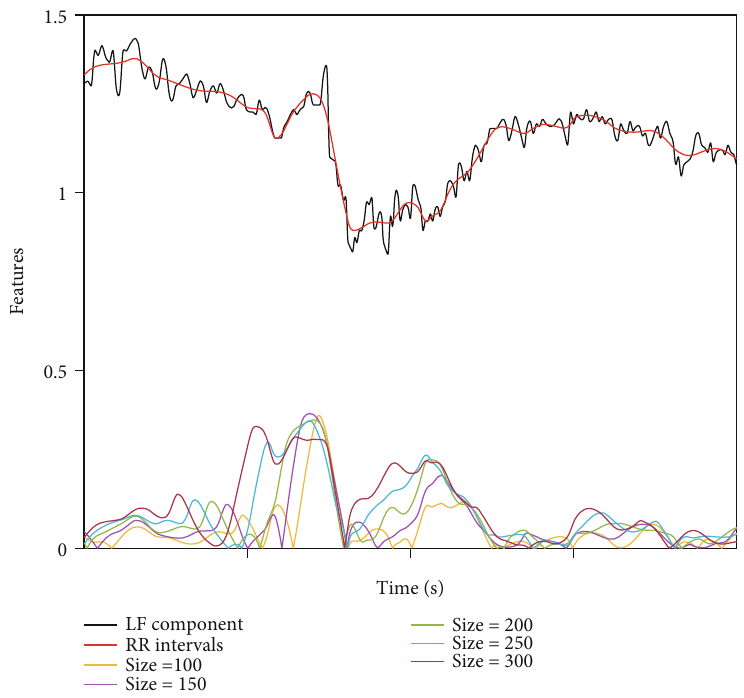
Figure 3: The extracted features corresponding to window sizes between 100 and 300 sampling